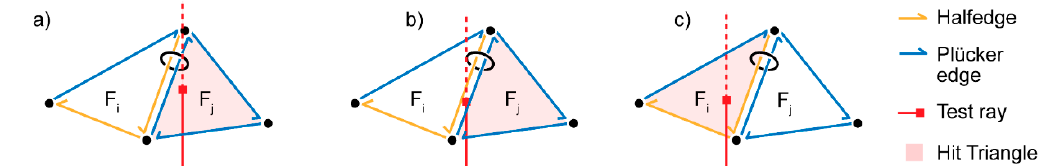
Figure 7. Three possible scenarios for a ray-triangle intersection using Plücker coordinates. ( a ) Ray hits exactly one triangle with a dominant edge between. ( b ) Ray hits two triangles at an adjacent dominant edge. ( c ) Ray hits exactly one triangle without a dominant edge.